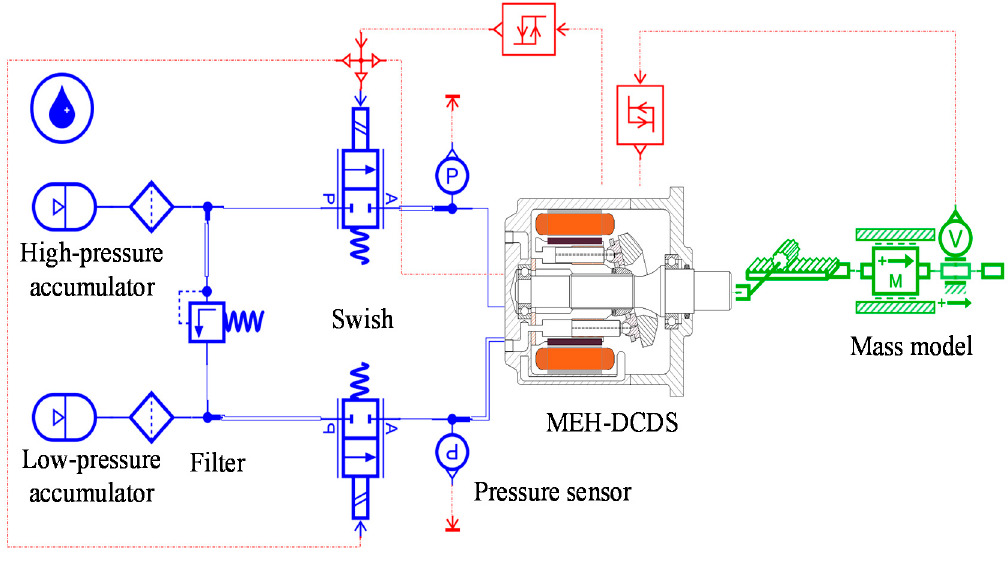
Figure 6. MEH-DCDS model constructed using the AMESim software.